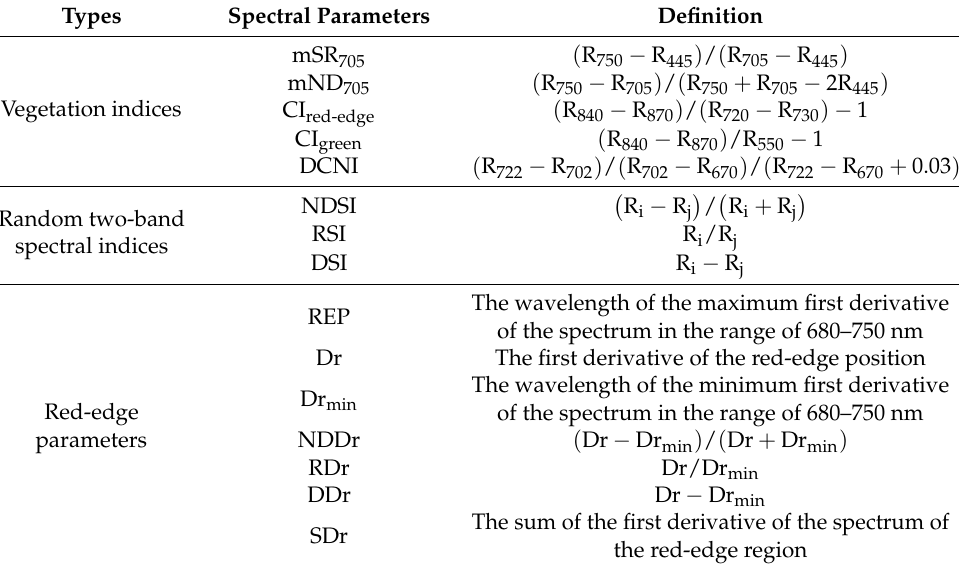
Table 1. Spectral parameters and